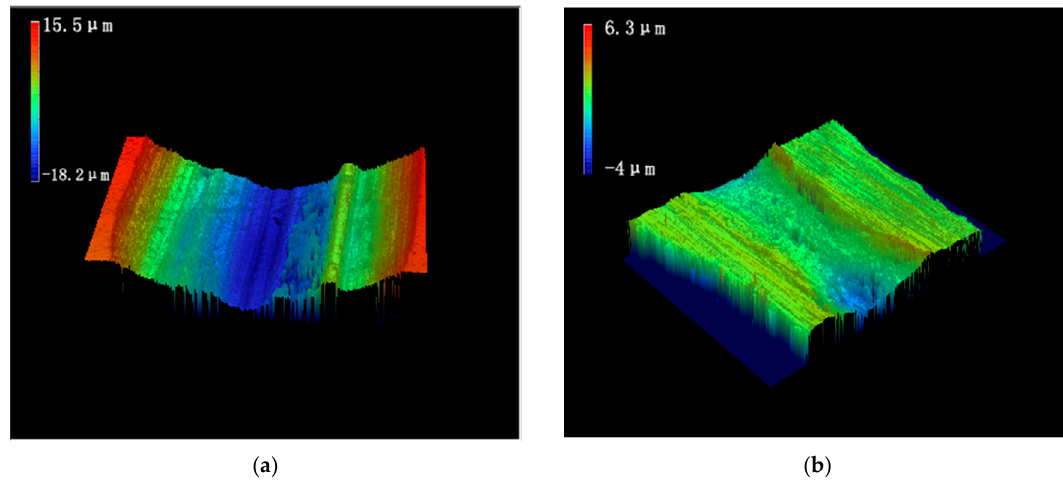
Figure 10. Friction and wear diagram of cladding layer with different TiC powder ratios: ( a ) 12# sample: 1.2 kW, 5 mm/s, 1000 L/h, 20% TiC; ( b ) 11# sample: 1.2 kW, 5 mm/s, 1000 L/h, 60% TiC.